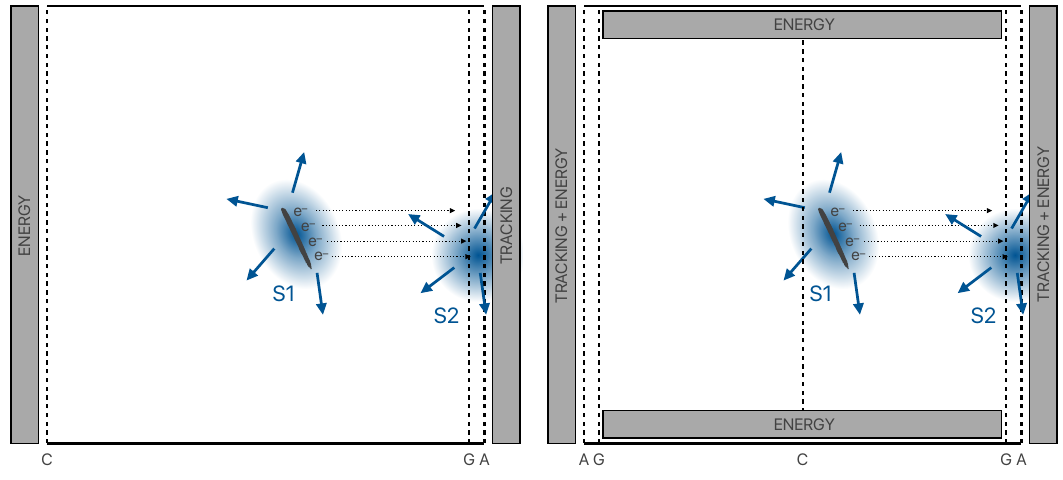
Figure 1 . The NEXT detector concept in two different configurations. In the so-called asymmetric design (left panel), the active volume of the detector consists of a single drift region, between cath- ode (C) and gate (G), and a single EL gap, between gate and anode (A). An array of photosensors behind the anode measures the start-of-event signal (S1) and the energy of the event (S2), whereas track reconstruction is performed with the S2 signals registered by a matrix of small photosensors placed behind the anode. The internal walls of the active volume are covered with reflective material (e.g., PTFE) to improve light collection. In the symmetric design (right panel), the active volume is divided by a central cathode into two identical drift regions equipped with an EL gap and a photosen- sor array that measures both tracking and energy. Alternatively, the reflective walls can be replaced by wavelength-shifting light guides coupled to photodetectors outside of the sensitive